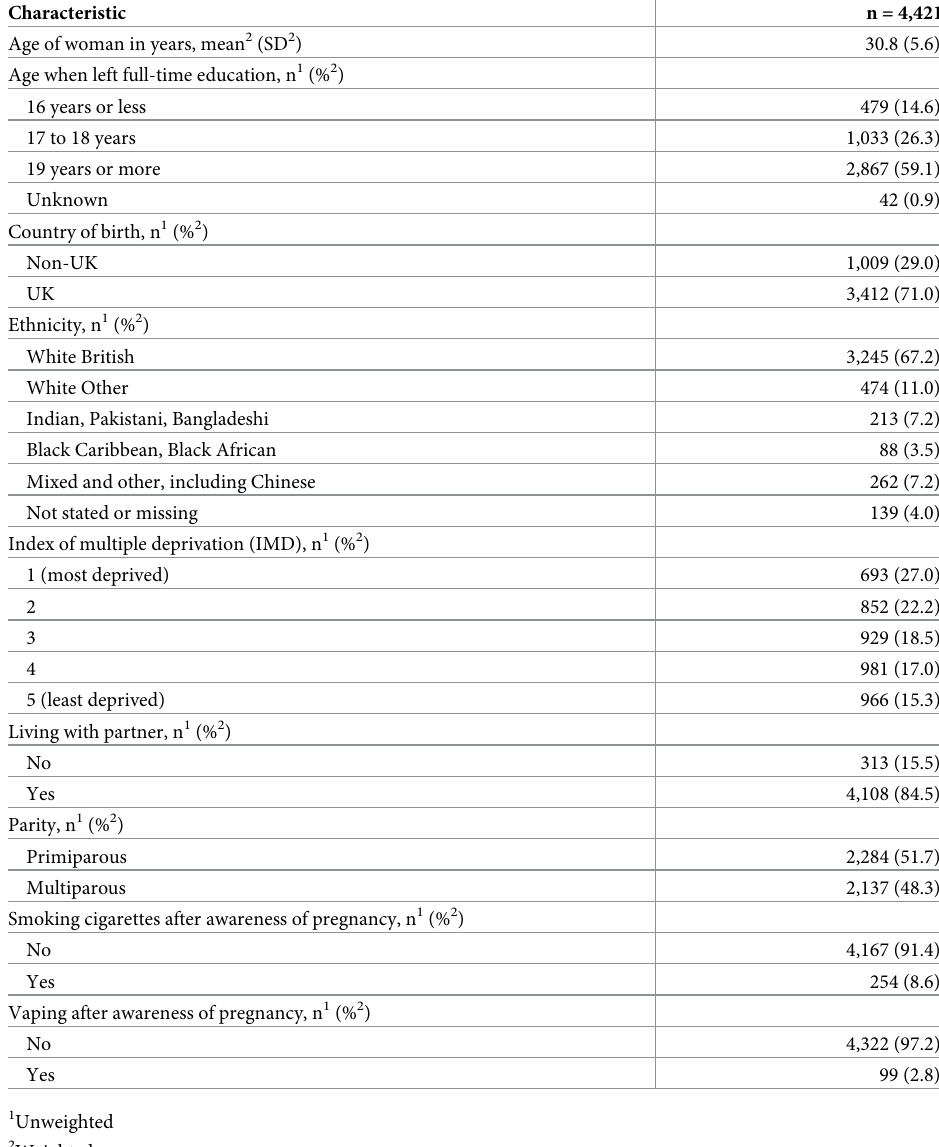
Table 1. Characteristics of women in the